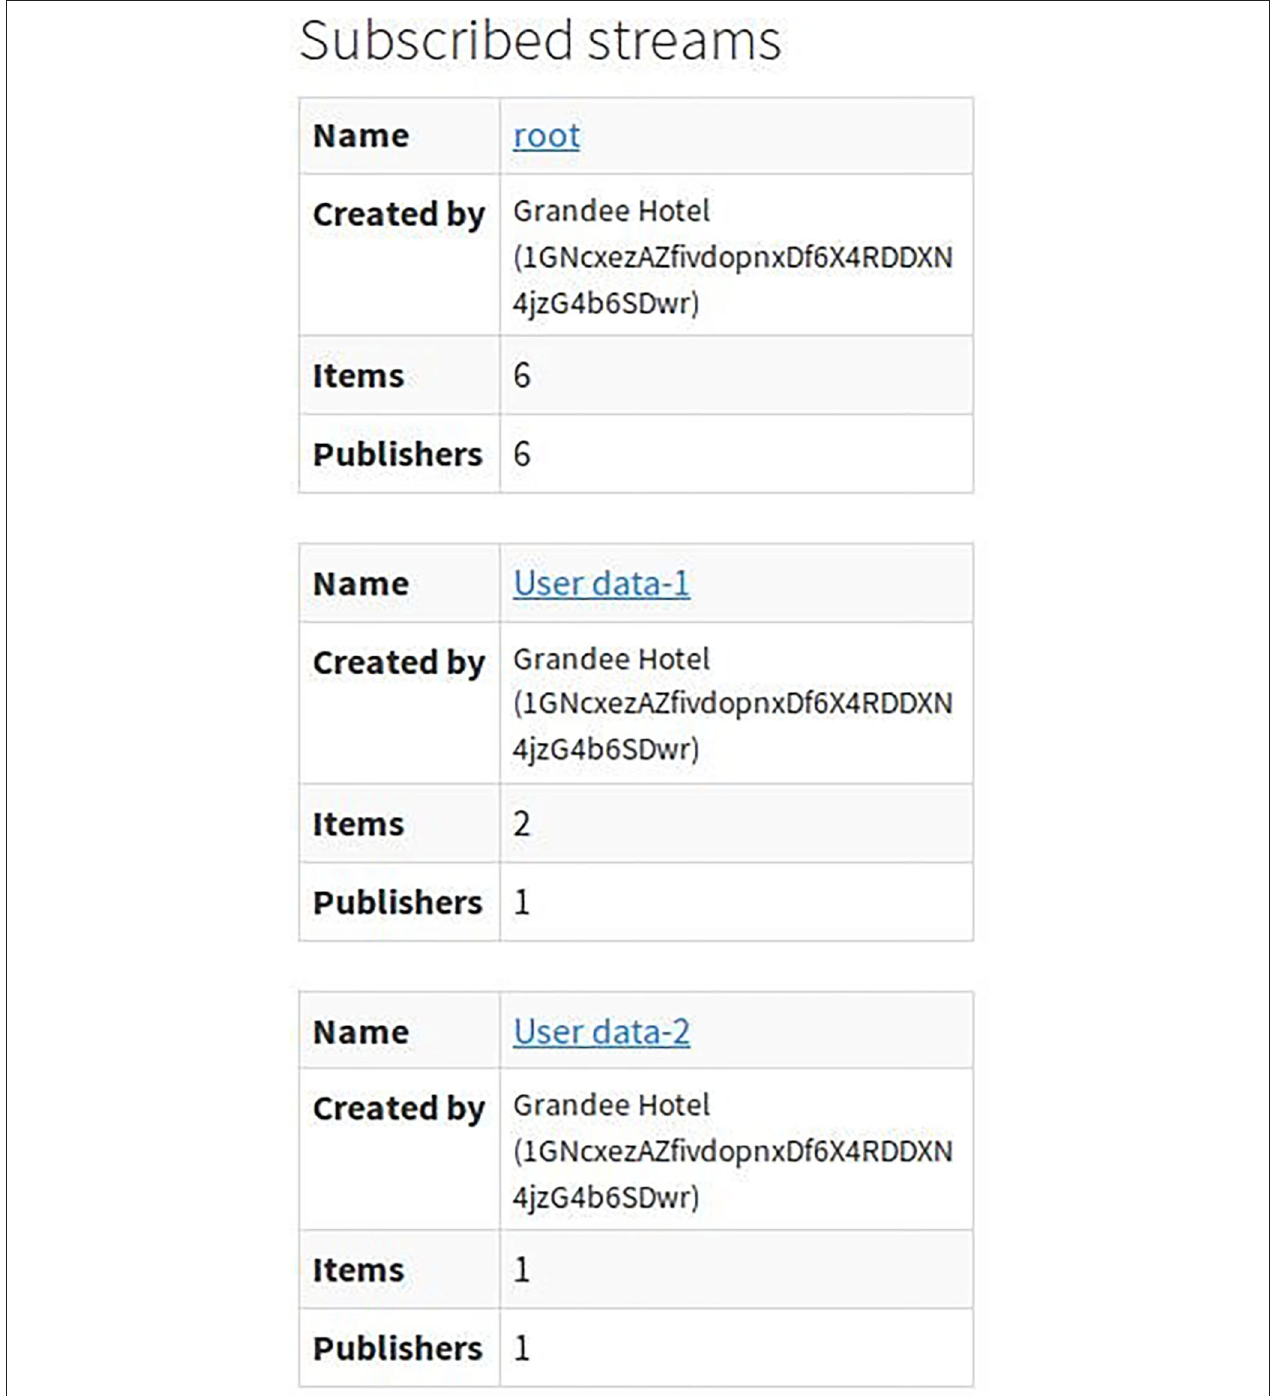
FIGURE 6 | List of the Streams created by Node